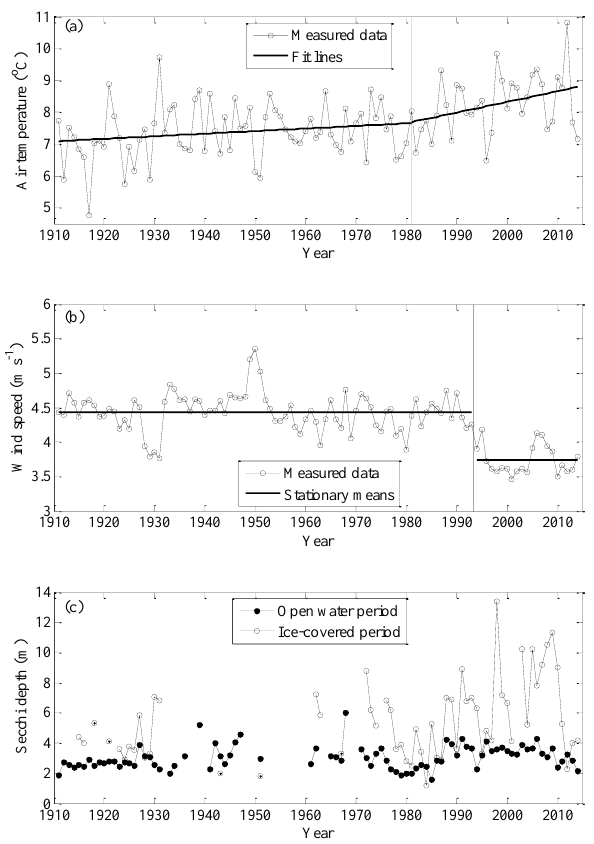
Figure 1. Historical record of annual average (a) air temperature and (b) wind speed in Madison, WI, USA, and (c) Secchi depth in Lake